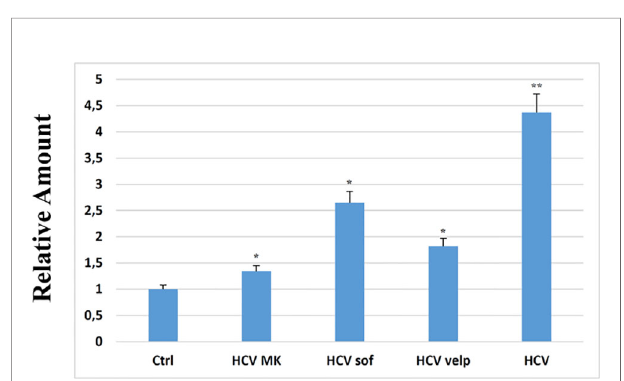
( Figure 5B ), con fi rming that HCV infection may act not only on